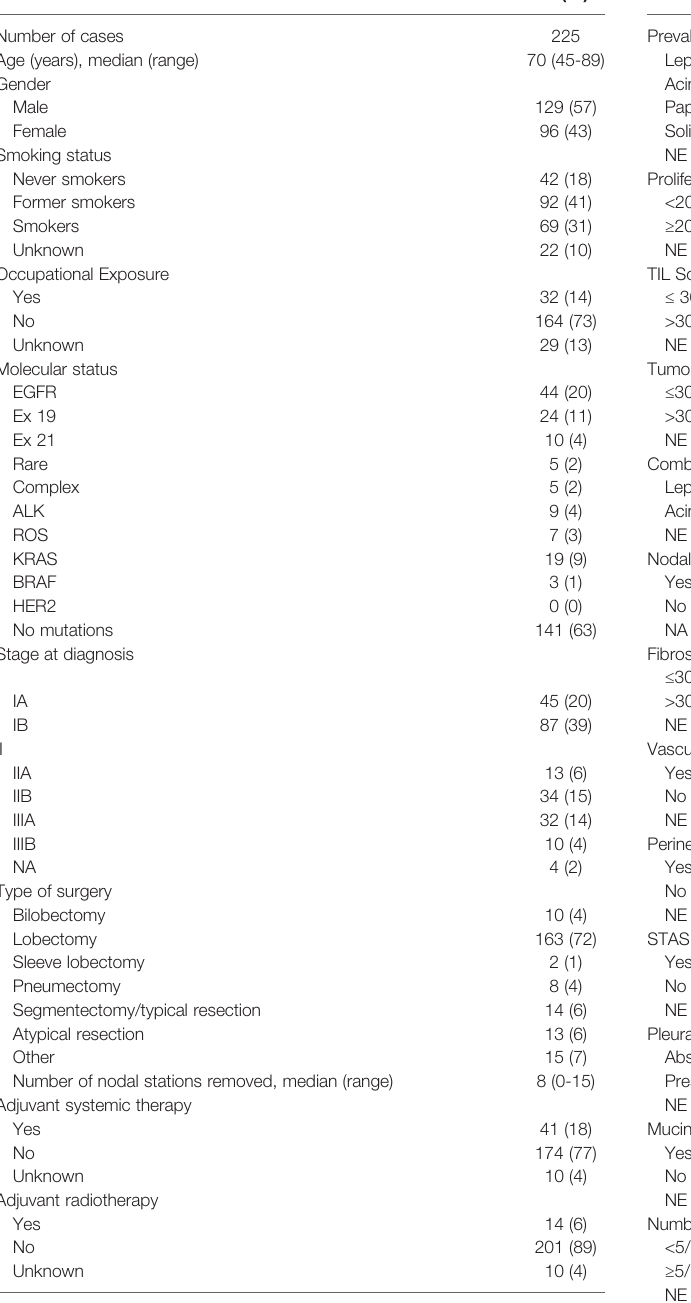
TABLE 1 | Patient